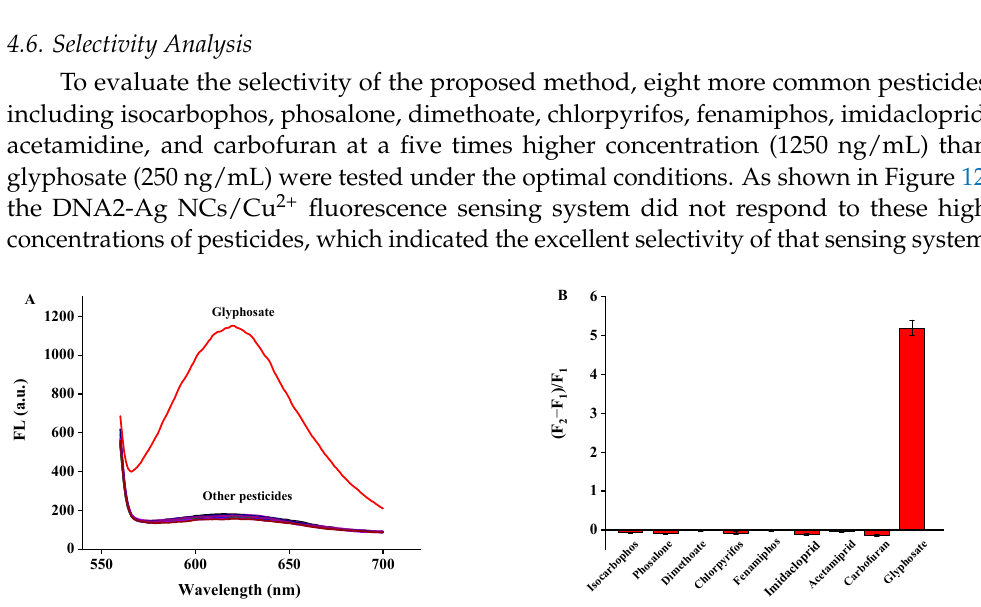
Figure 12. Selectivity of the assay for various pesticides. ( A ) Fluorescence; ( B )